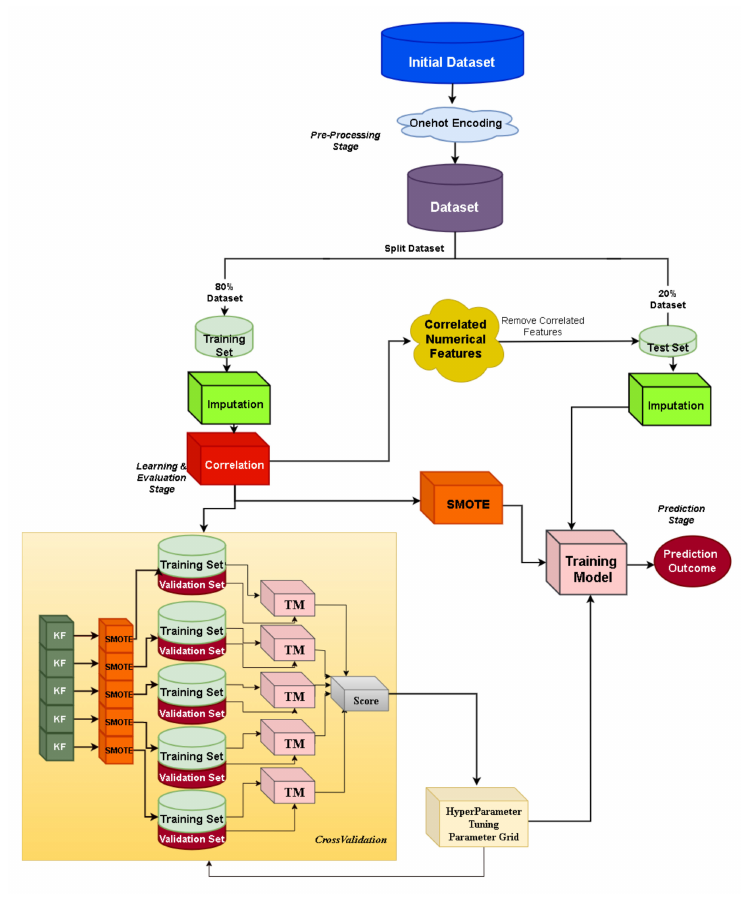
Figure 1. Custom machine learning pipeline: